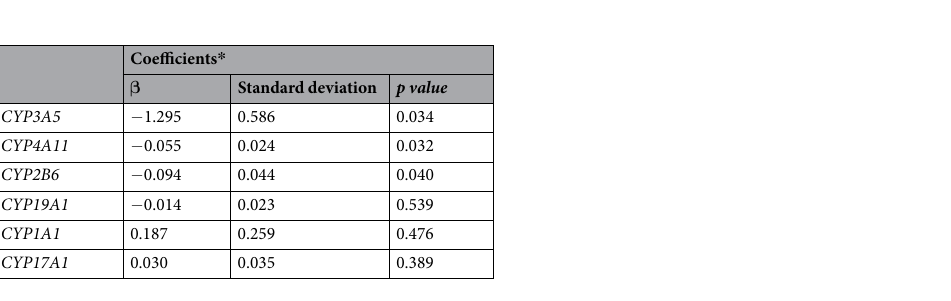
Table 2. Linear regression analysis of the relationship between the blood level of tacrolimus and the gene expression level. * Dependent variable: the blood level of tacrolimus, adjusted by age, sex, dosage of tacrolimus, and